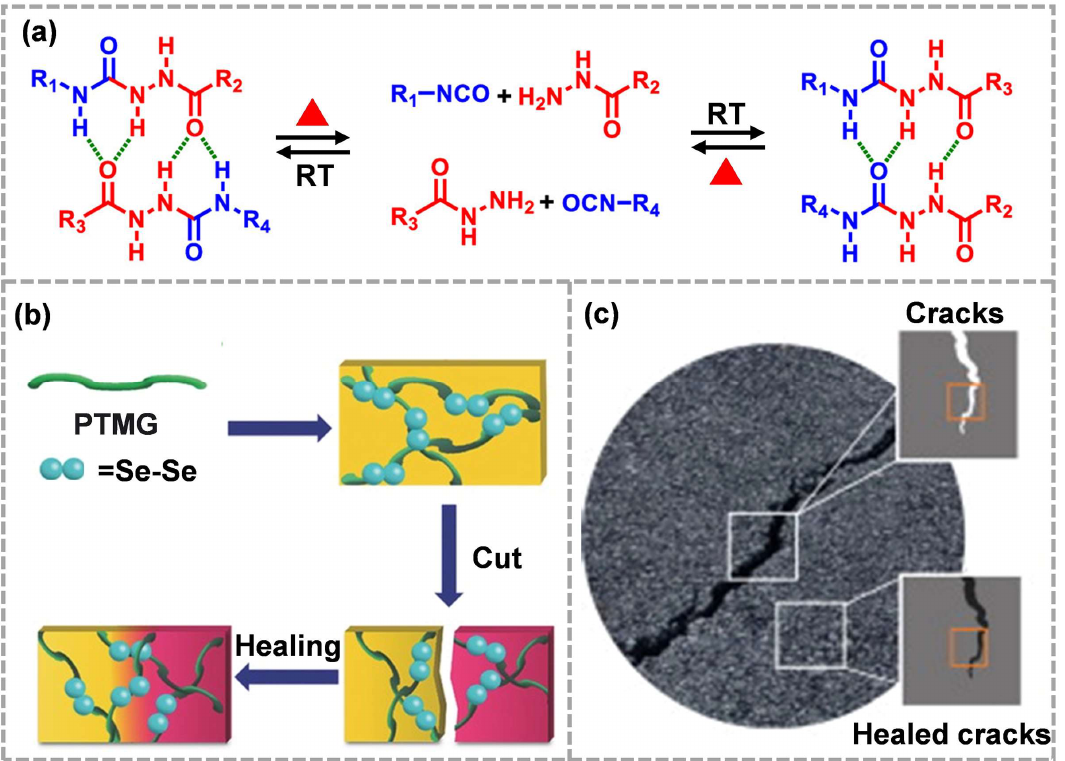
Figure 6. ( a ) Dynamic chemistry of ASCZ groups (reproduced from Ref. [24] with permission; Copyright American Chemical Society, 2020), ( b ) visible-light-induced self-healing process of diselenide-containing polymer (reproduced from Ref. [88] with permission; Copyright Wiley, 2015), ( c ) crack healing of composites using diselenide-containing polymers as binders (reproduced from Ref. [34] with permission; Copyright Elsevier, 2021).